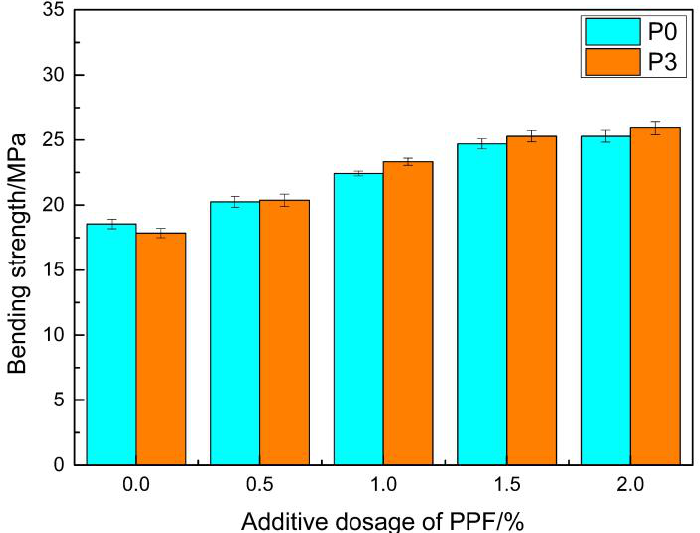
Figure 12. The relationship between the polypropylene fiber (PPF) content and bending strength after thermal shock.